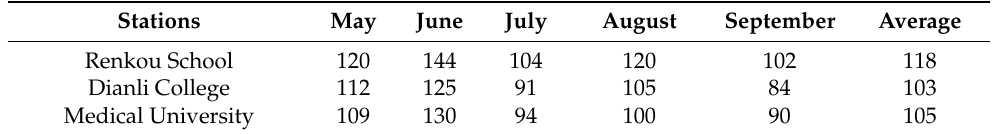
Table 4. Comparison of mean O 3 -8h-90per concentrations ( µ g/m 3 ) at three monitoring stations in Tai’an from May to September